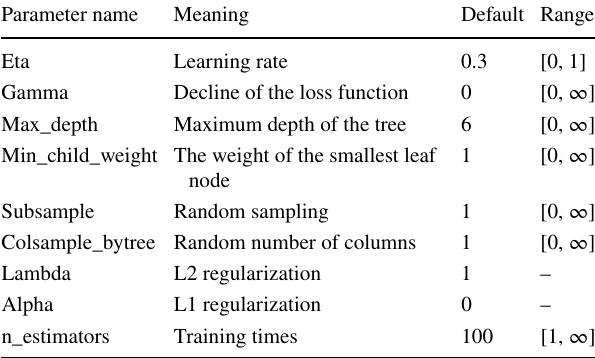
Table 1 The statistics of the three datasets Dataset